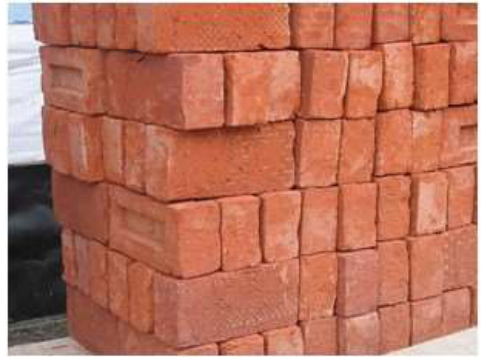
Figure 2. Scrubbed surface of new brick specimens.